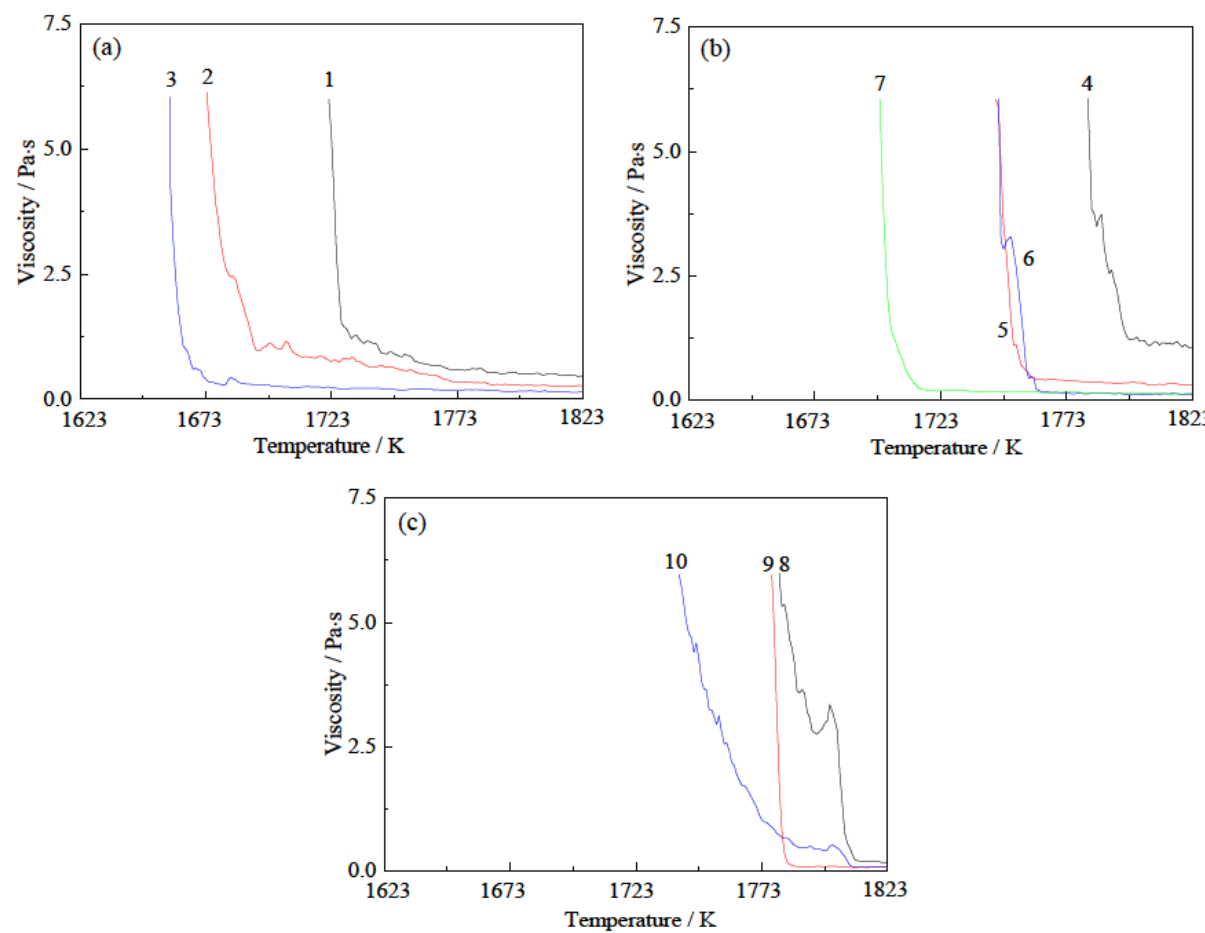
Figure 2: Viscosity curves of La 2 O 3 -SiO 2 -FeO ternary basic slags. (a) 45 mass% La 2 O 3 -SiO 2 -FeO slags, (b) 50 mass% La 2 O 3 -SiO 2 -FeO slags, (c) 55 mass% La 2 O 3 -SiO 2 -FeO slags. Table 2: Constant-Temperature Viscosity and Break Temperature of La 2 O 3 -SiO 2 -FeO-Al 2 O 3 Slag. Sample